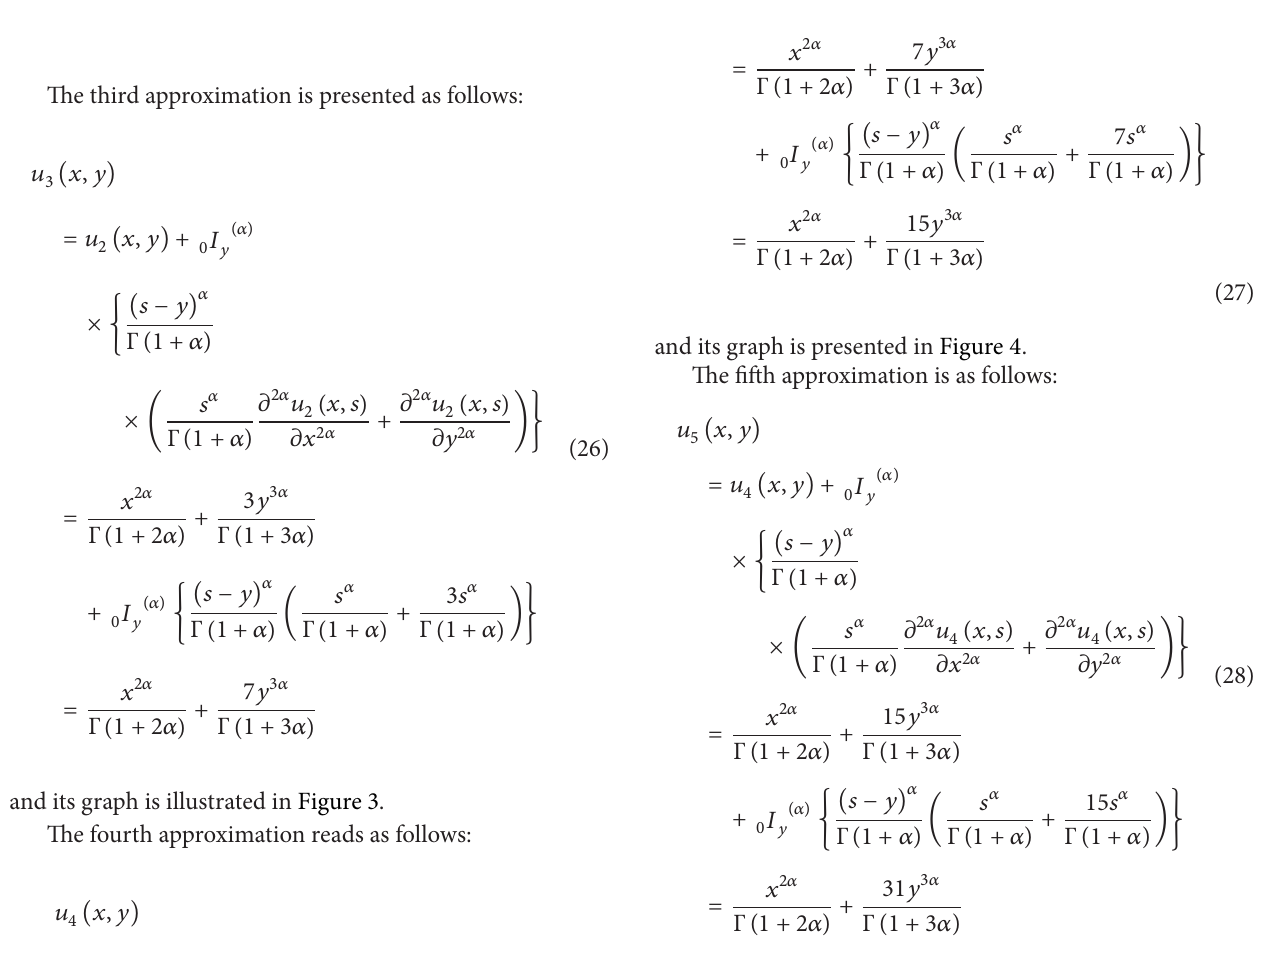
Figure 3: The plot of 𝑢 3 (𝑥,𝑦) with the parameter 𝛼 = ln 2/ ln 3 .